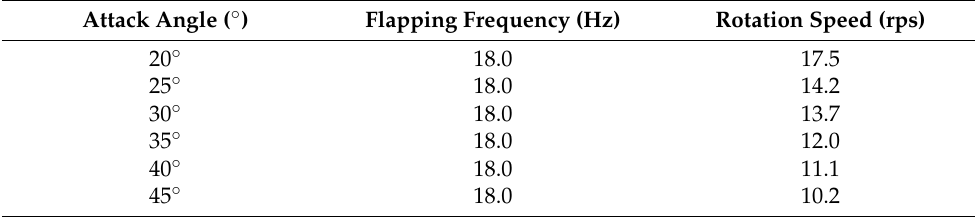
Table 2. The parameters of the FWR with different attack